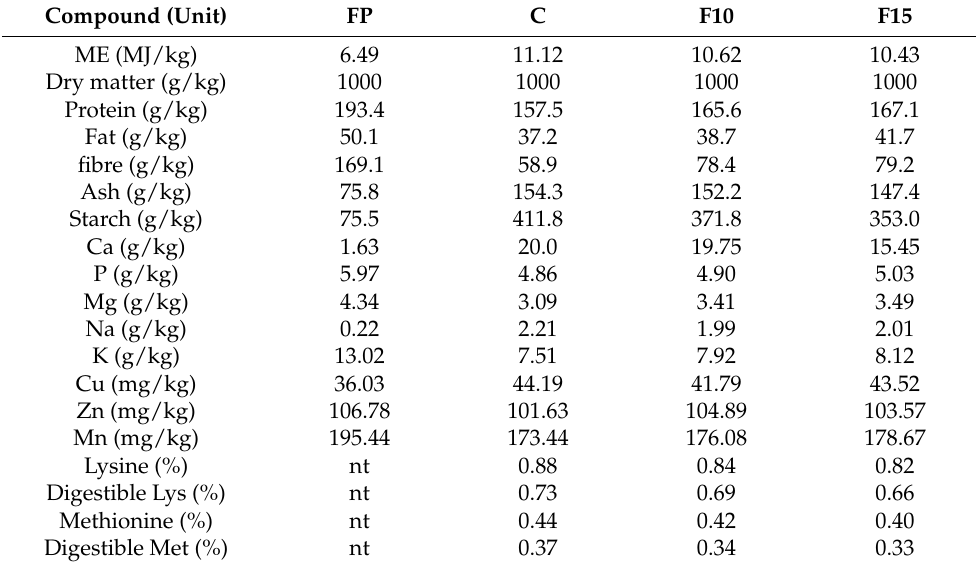
Table 1. Composition of fermented products and diets.